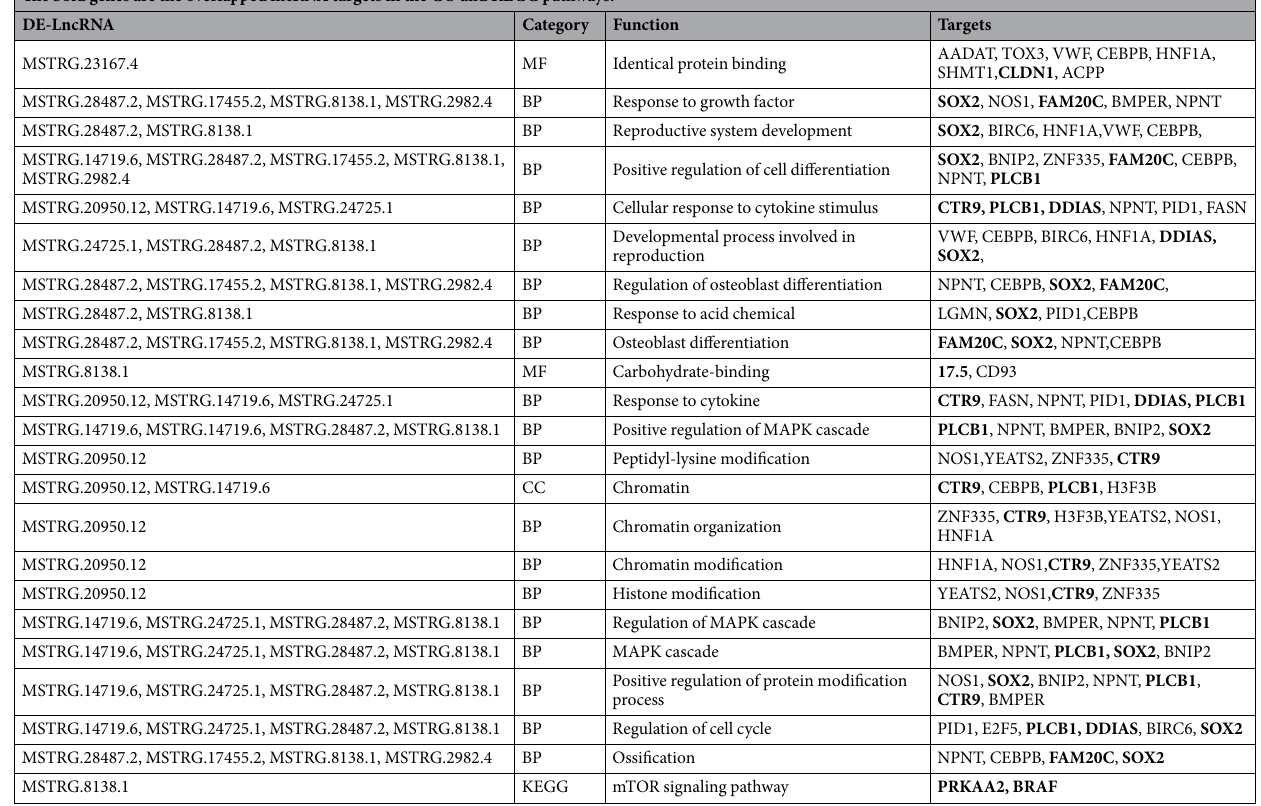
Table 3. Summary of the eight key differentially expressed long non-coding RNA (lncRNA) associated with duration of fertility trait in the egg-laying